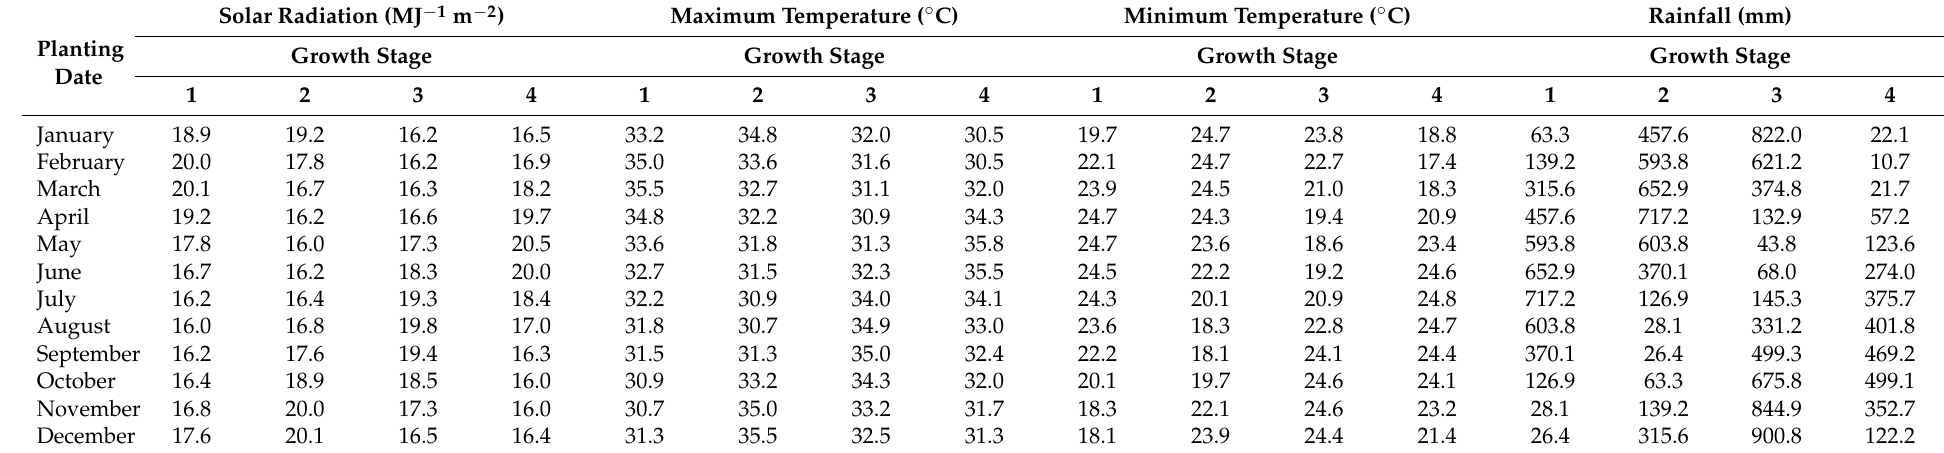
Table 5. Average values over ten locations and 30 years (1988–2018) for solar radiation, maximum temperature, minimum temperature, and total amount of rainfall for the four different growth stages of